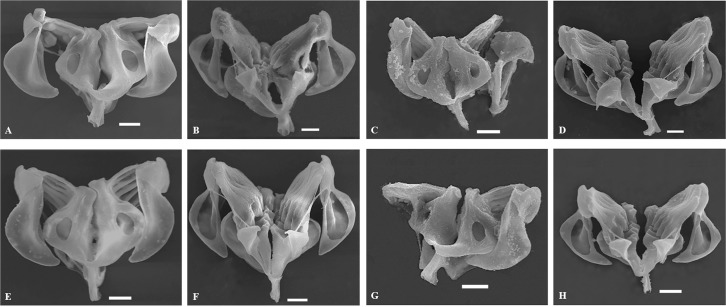
Scanning electron micrographs of the trophi dorsal and ventral view for B. dorcas (A, B), B. elevatus sp. nov. (C, D), B. calyciflorus s.s. (E, F) and B. fernandoi sp. nov. (G, H).